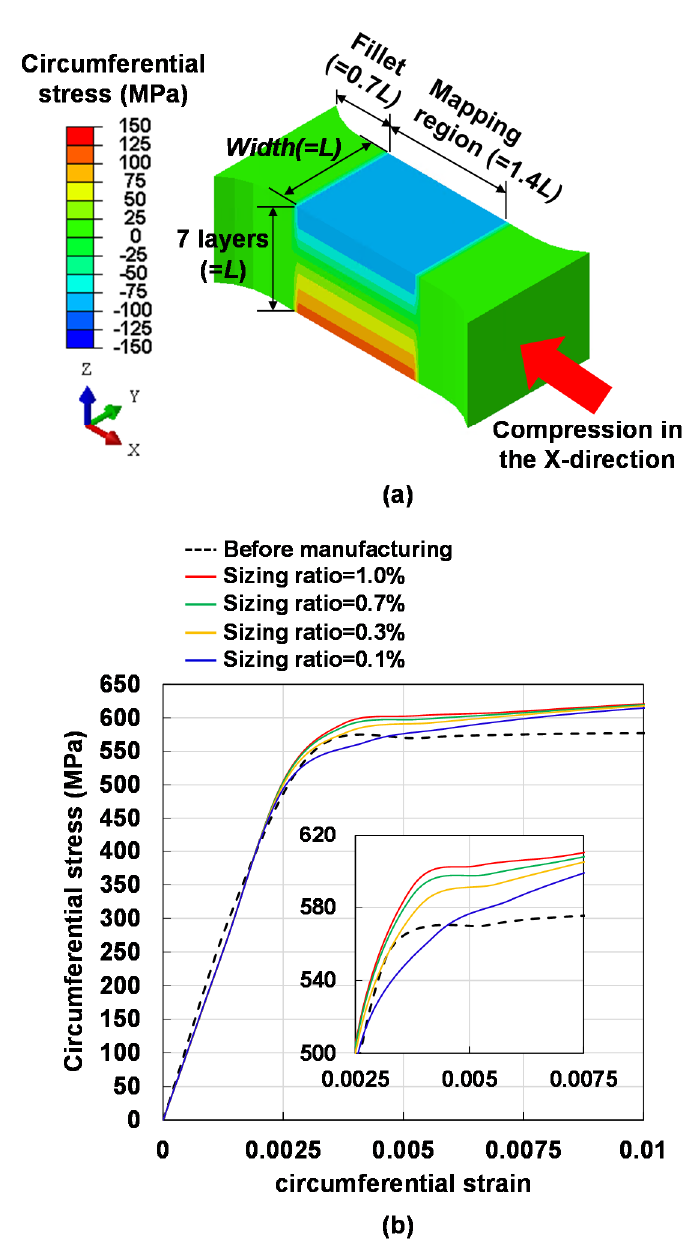
Figure 12. Compression test: ( a ) specimen model for the compression test; ( b ) compressive stress–strain curves for various sizing ratios.